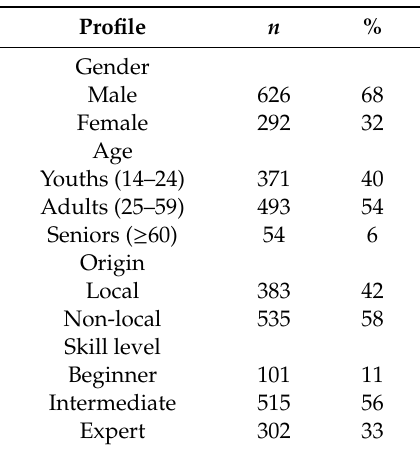
Table 2. Respondents